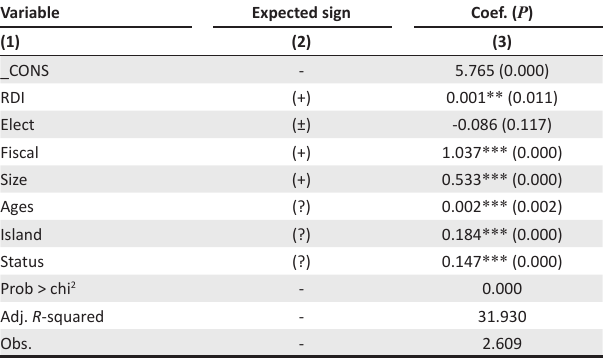
Variable Y = Disbudg. Explanation of operationalisation of variables in Table 1. *** , ** , * , P -value significant 1 % , 5 % and 10 % .